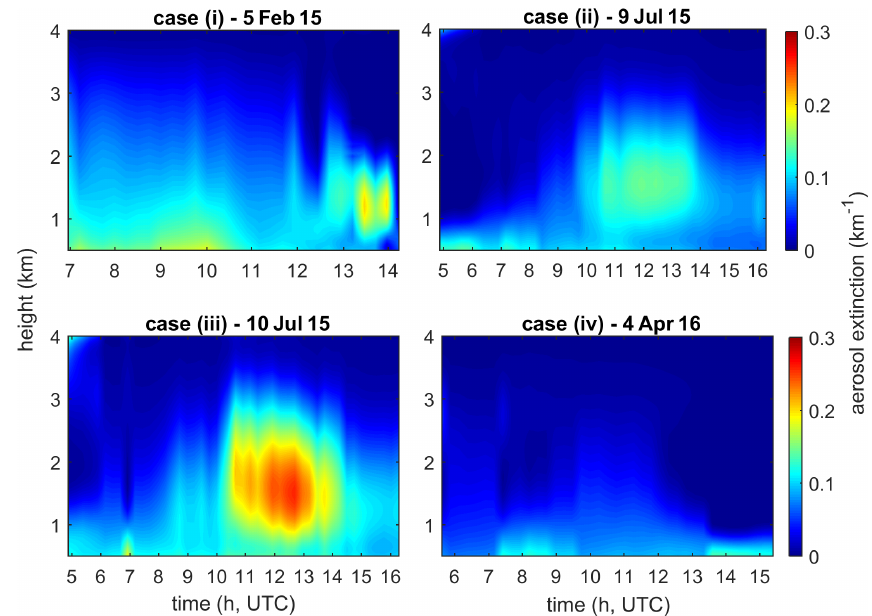
Figure 4. MAX-DOAS-retrieved aerosol extinction vertical distributions (from instrument’s height up to 4kma . s . l . ) for the four case studies over the urban area ( S ). The spatial and vertical resolution of the retrievals is 50m and 15min, respectively.